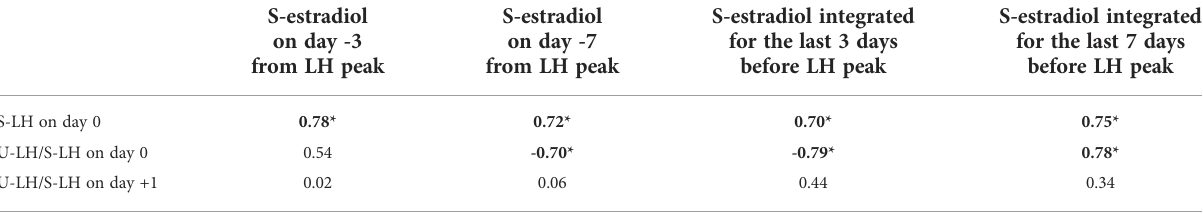
TABLE 1 Correlation between serum estradiol concentrations and S-LH concentrations or the ratio of total luteinizing hormone immunoreactivity (LH-ir) in urine to intact LH-ir in serum (representing the non-intact LH-ir in urine) around the days of LH peak.